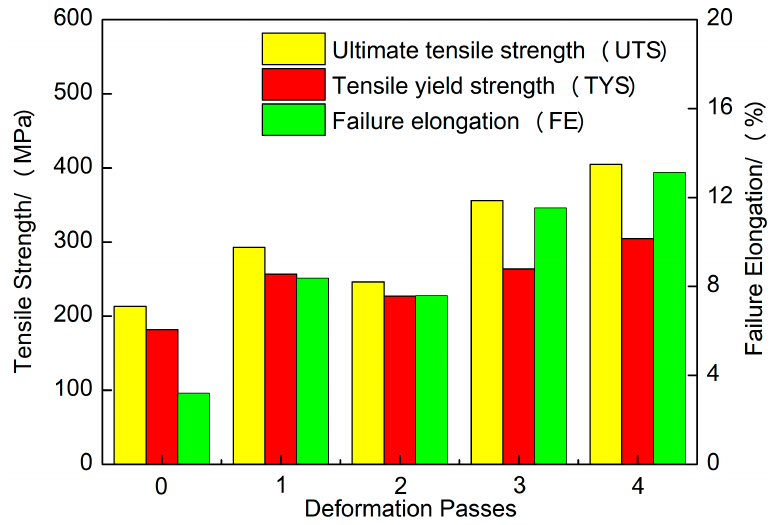
ff erent deformation